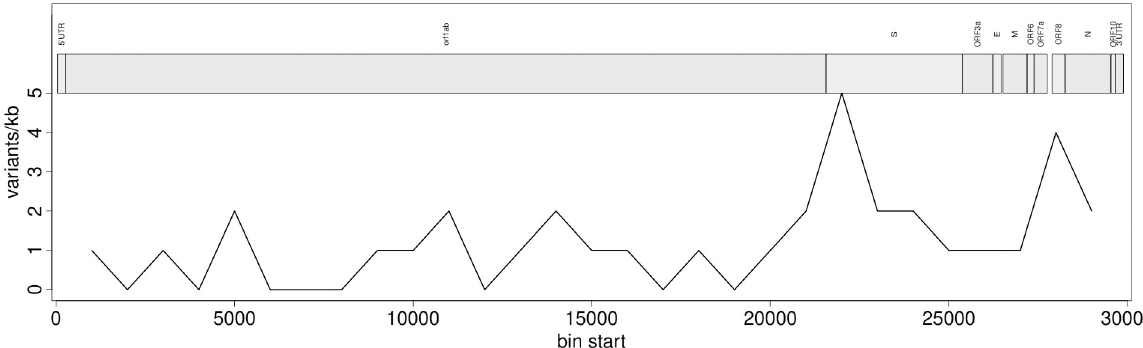
Fig 4. Example of the SNP density of sample S11 across the reference genome. The x-axis shows the genomic position, whereas the y-axis represents the number of SNPs within sliding windows.